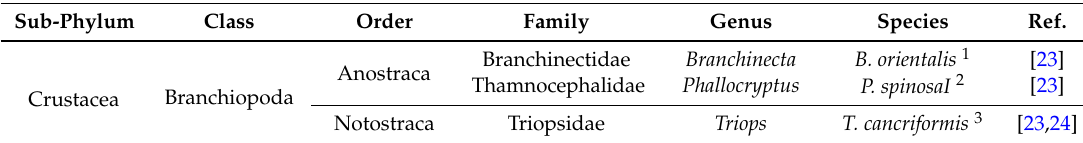
Table 7. List of crustaceans from the National Park of Urmia Lake.